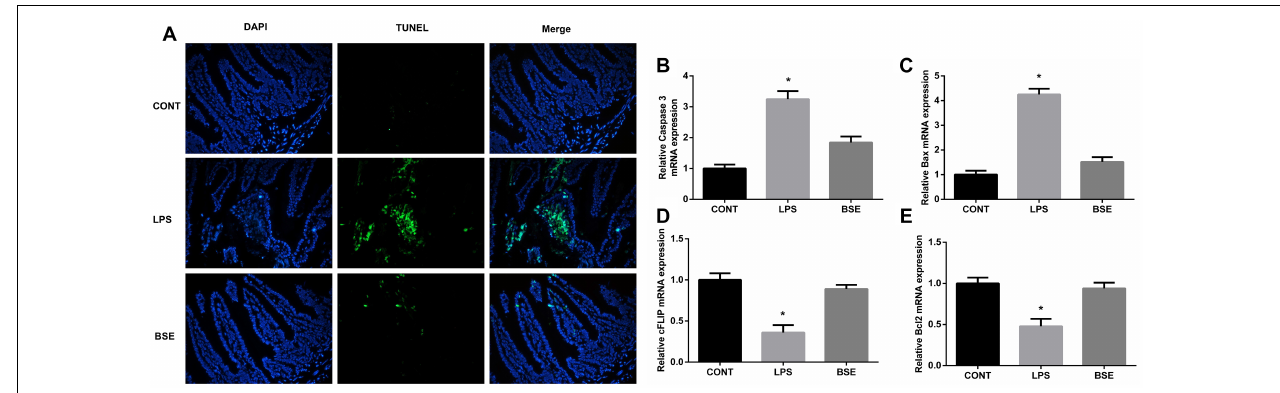
FIGURE 4 | Effects of Blidingia sp. extract on apoptosis in ileum of lipopolysaccharide – challenged mice. (A) Representative TUNEL (green) staining (200 × ); Nuclei were stained with DAPI (blue). Relative mRNA expression of Caspase 3 (B) , Bax (C) , cFLIP (D) , and Bcl2 (E) . CONT, mice gavaged with sterile saline; LPS, mice injected with lipopolysaccharide; and BSE, mice gavaged with Blidingia sp. extract and injected with lipopolysaccharide. Values are expressed as mean ± SEM, n = 8; ∗ p < 0.05.